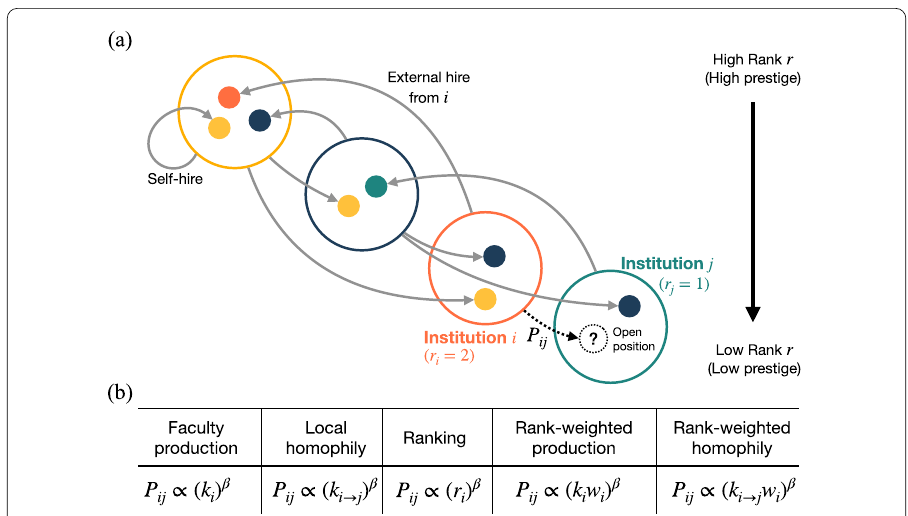
Figure 1 Schematic representation of five simple models for faculty hiring. ( a ) Four large circles represent institutions, and filled circles represent faculty who graduated from the color-matched institutions. Grey links denote faculty hiring, including self-hiring. When a department j has an open position (a retirement), a new hiring event from institution i will occur with probability P ij , determined by a hiring model. All institutions are assigned a prestige rank, where a high rank r i denotes high prestige, calculated via SpringRank [6]. ( b ) Mathematical definition of P ij for five hiring models, showing how each model formalizes a different notion of institutional prestige: the number of faculty produced by an institution i ( k i ), the number of previous hires from i at j ( k i → j ), the rank of i ( r i ), the weighted number of faculty produced by i ( k i w i ), and the weighted number of previous hires from i at j ( k i → j w i ) with a preference strength β of an institution’s